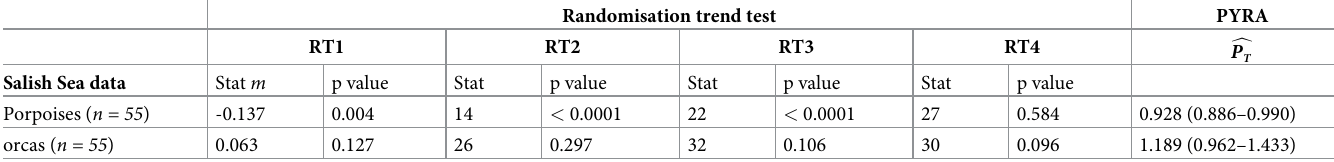
with the four randomisation trend tests applied to the Salish Sea data set. T